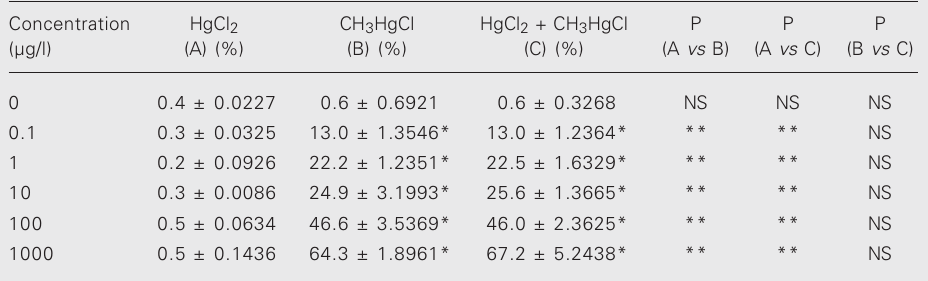
Table 3. Distribution of cells with polyploid aberrations (%) following exposure to different concentrations of mercury chloride and methylmercury